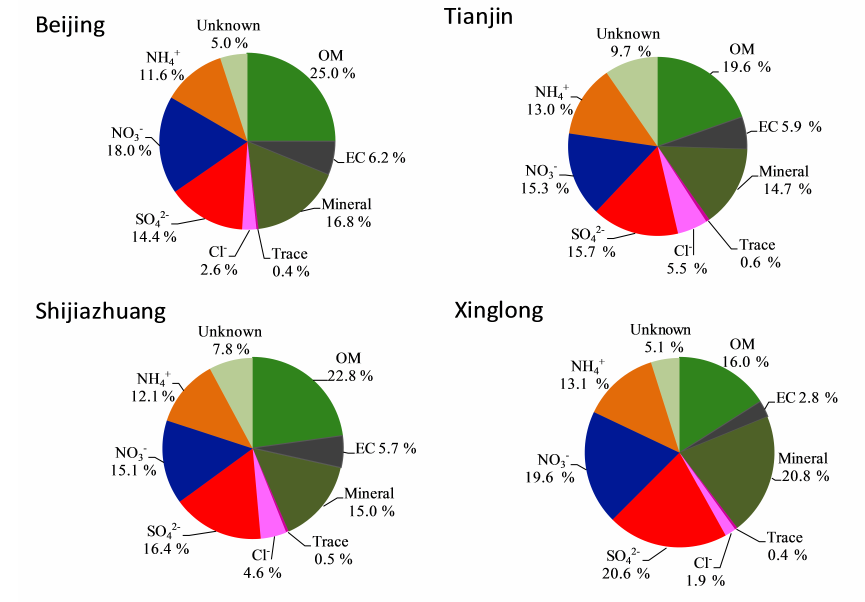
Figure 3. Pie charts depicting the percentages of the major chemical components in gravimetric PM 2 . 5 based on annual